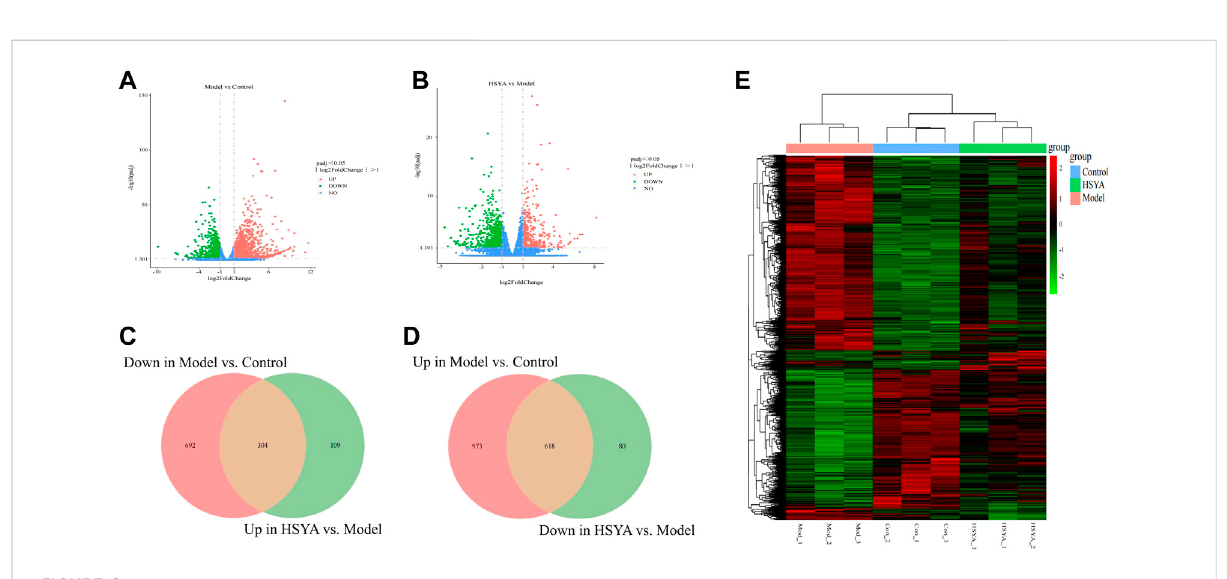
FIGURE 6 Quantitative analysis of DEGs. (A,B) Volcanic map of DEGs among groups; (C,D) Venn diagram of DEGs among groups; (E) Heat map among liver